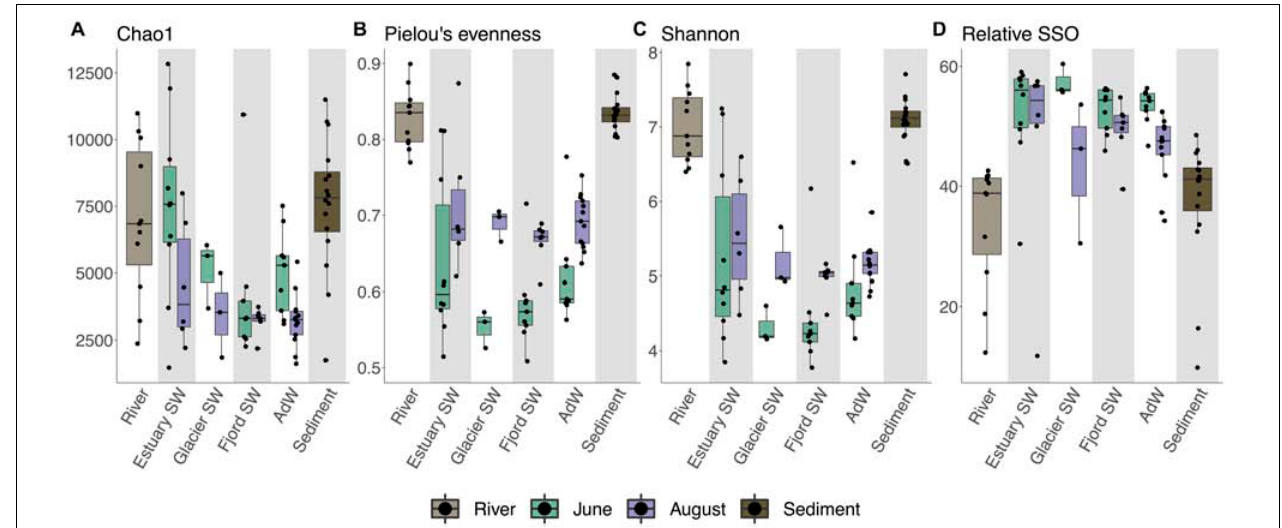
FIGURE 2 | Boxplots showing alpha diversity indices according to water type and seasonal groupings. Individual data are given by black points, boxplots show the median values (line), interquartile range (box), and range of the data (whiskers). Alpha diversity indices (indicated on the left axis) were calculated as Chao1 (A) , Pielou’s index for evenness (B) , Shannon’s diversity index (C) , and rare biosphere as singletons (SSO) generated after rarefaction (number of OTUs occurring only once in the sample after rarefaction) (D) . nOTU and ACE (not shown) followed the same trend as Chao1, and inverse Simpson’s followed the same trend as Shannon’s. The bottom axis indicates the habitat (sediment, river) or water type (water column). A post hoc Dunn’s test was performed on the Kruskal-Wallis test output to test for differences between seasonal groups and water type groups ( Supplementary Figures 2, 3 and Supplementary Table 4